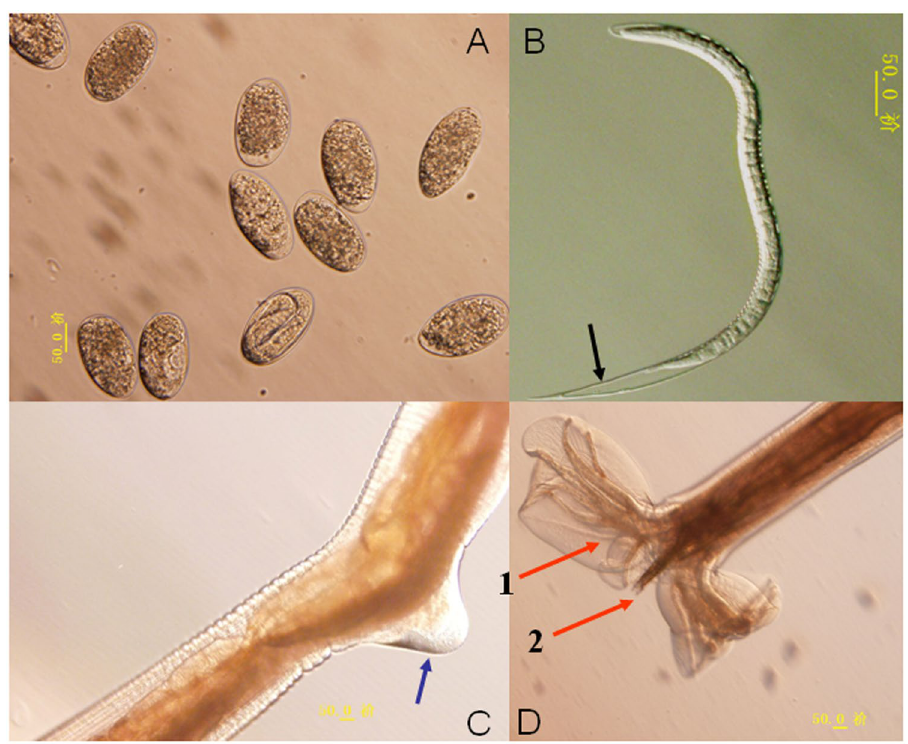
Figure 4. H. contortus life-cycle stages. ( A ) H. contortus egg. ( B ) H. contortus L 3 larva. Slender larva, tail of sheath medium length ( > 50 µ m < 100 µ m), tapering to point and often kinked. ( C ) H. contortus adult female vulval flap. The blue arrow is pointing to the vulval flap. ( D ) H. contortus adult male bursa. The red arrows are pointing to the capulatory bursa (1) spicules used to hold open the female worms genital opening